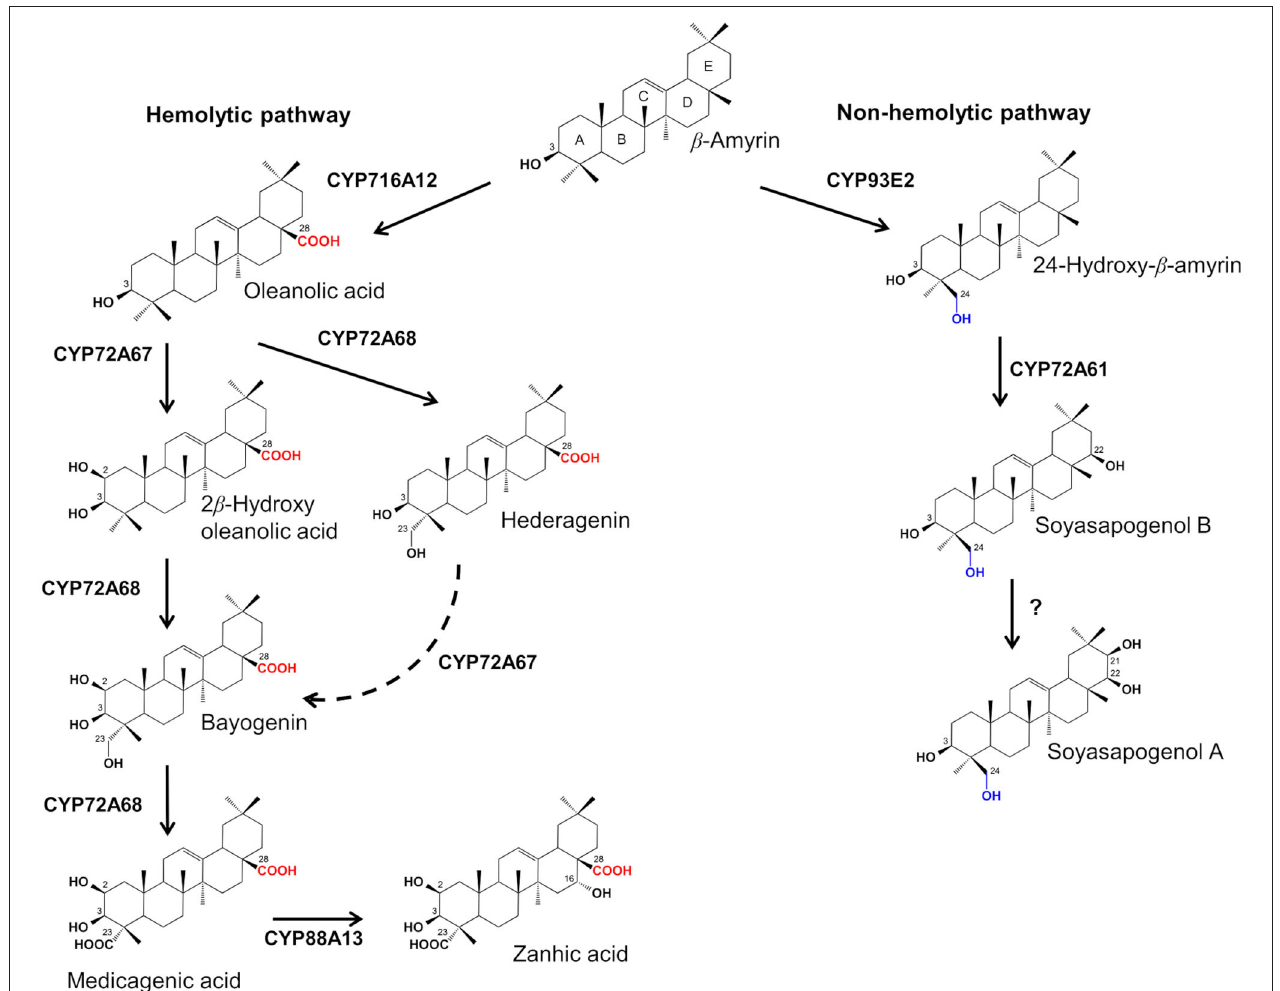
FIGURE 1 | Biosynthetic pathway of triterpene sapogenins in Medicago truncatula